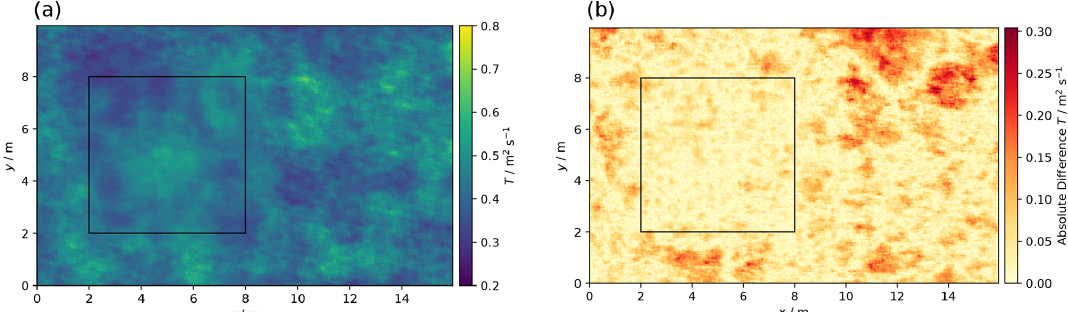
Figure 29. One realization of the conditioned SRF (a) and absolute difference (b) between the “true” (Fig. 27) and conditioned transmissivity, showing increasing differences with distance from the conditioning area (rectangle).